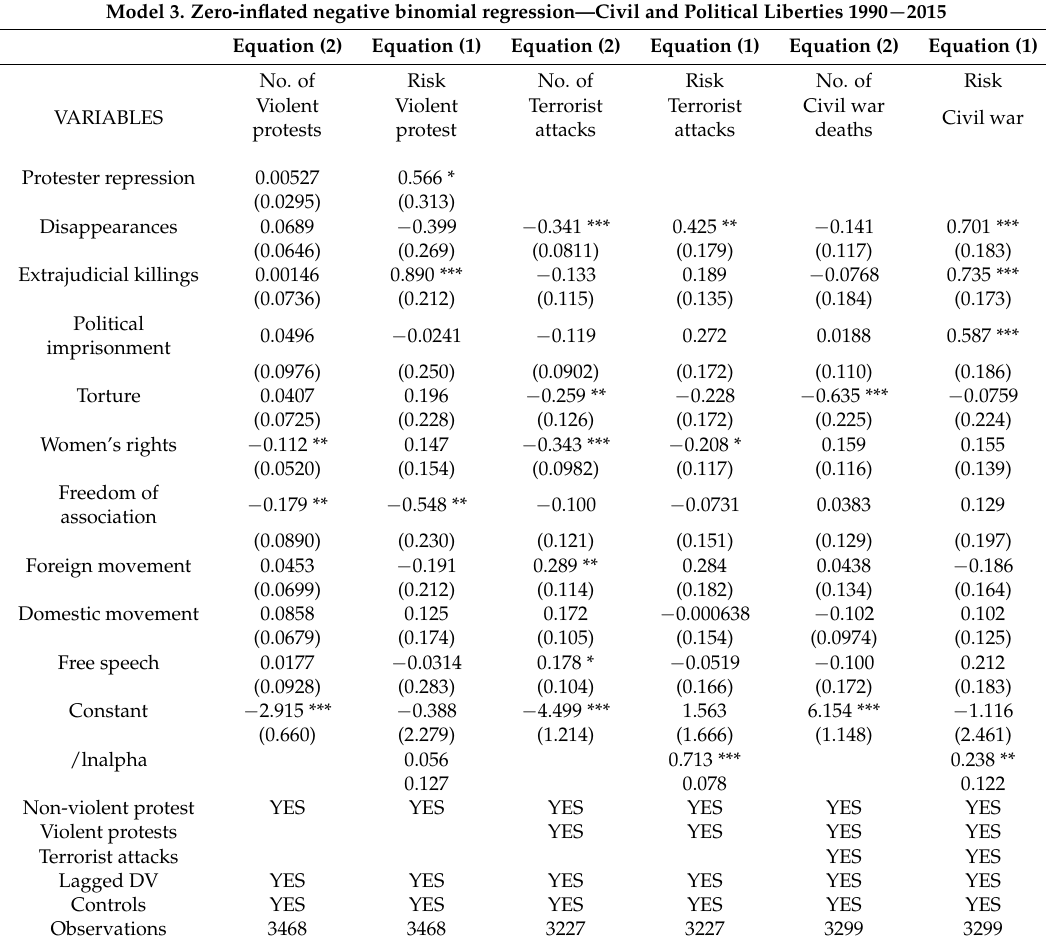
Table 4. Civil and Political Liberties and Internal